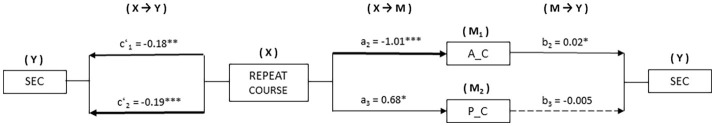
Mediation model of parenting styles on the relationship between repeating a year and school-based everyday creativity. *p < 0.05; **p < 0.01; ***p < 0.001.